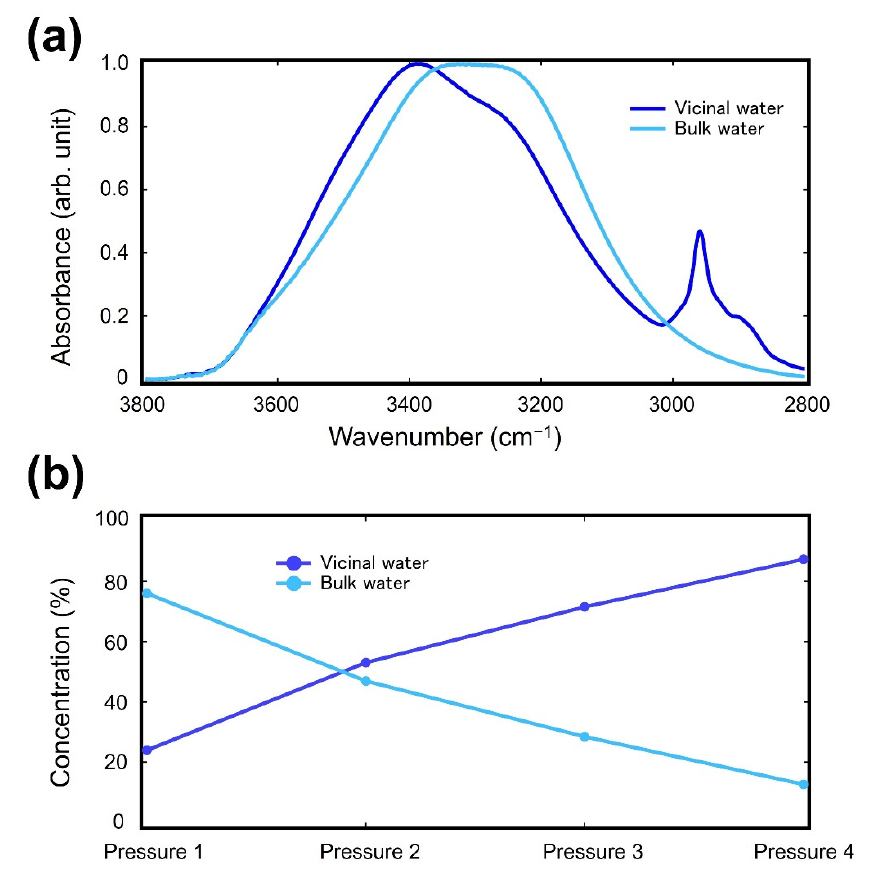
Figure 5. The results of ( a ) ATR-IR spectra and ( b ) concentration ratio by MCR-ALS analysis (clariti ® 1 day).